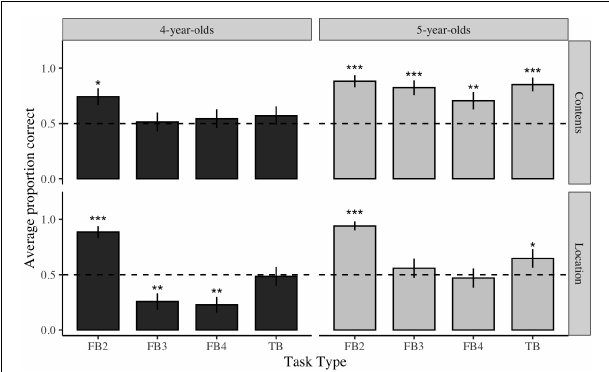
FIGURE 1 | Average performance on each ToM tak as a function of task version and age. ∗ p < 0 . 05, ∗∗ p < 0 . 01, ∗∗∗ p < 0 . 001. Dashed line represents chance performance on task.